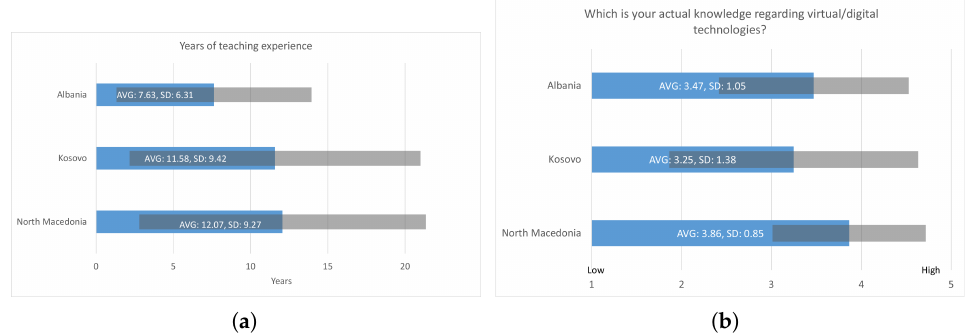
Figure 6. ( a ) Years of experience in teaching. ( b ) Knowledge regarding virtual and digital technologies.